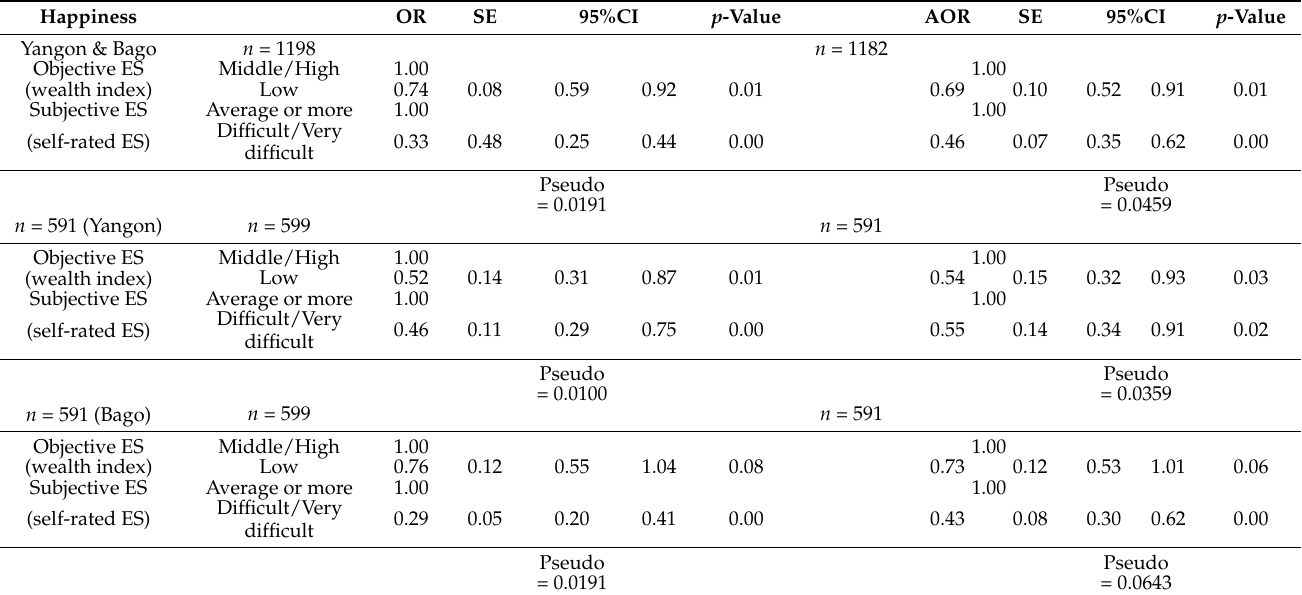
Table 2. Univariate and multivariate adjusted association between happiness and objective/subjective ES among the older adults in two Myanmar